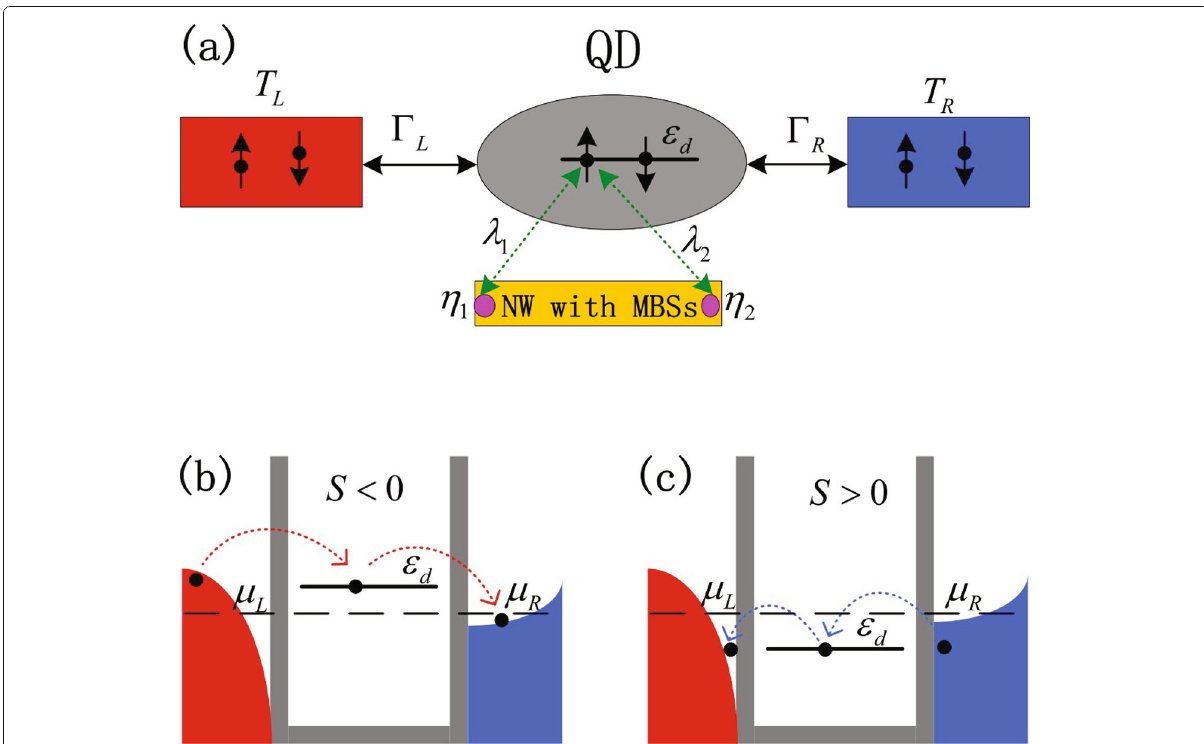
Fig. 1 Schematic of the model (color online). a Schematic of the simulation structure composed by a QD with gate-tunable energy level ε d which can be occupied by either a spin-up or a spin-down electron. The QD is connected to the left and right leads held at different temperatures with coupling strength (cid:6) L / R . The MBSs η 1 / 2 are formed in the ends of the semiconducting nanowire and are coupled to the spin-up electrons in the QD due to the chiral nature of the Majorana fermions with strengths of λ 1 and λ 2 , respectively. The energy state of spin-up electrons will be changed by MBSs-QD coupling, and then, the strength and sign of the thermopower S will be influenced. In the present model, we assume the temperature of the left lead T L is higher than that of the right one T R , and then, there are more electrons (empty states) being excited above (below) the chemical potential in the left lead than those in the right lead. b , c The electron tunneling processes and the resulted thermopower in the absence of MBSs-QD coupling. In b , the QD energy level ε d is above the chemical potential of the leads μ L / R = μ , and then, electrons from the occupied states > μ in the left hotter lead will tunnel through dot state ε < 0. ε d d to the empty state in the right colder lead, resulting in negative thermopopwer S In c , ε d < μ , and then, the sign of the thermopower is reversed